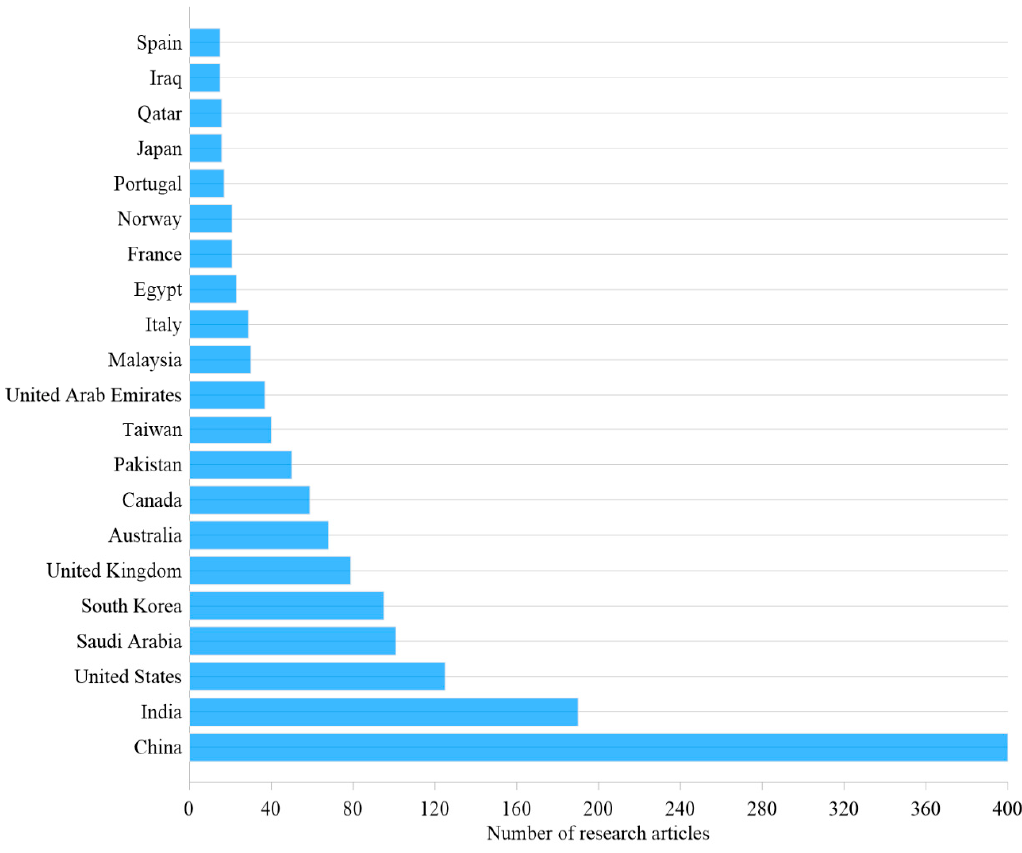
Figure 4. Distribution based on the country of publication.